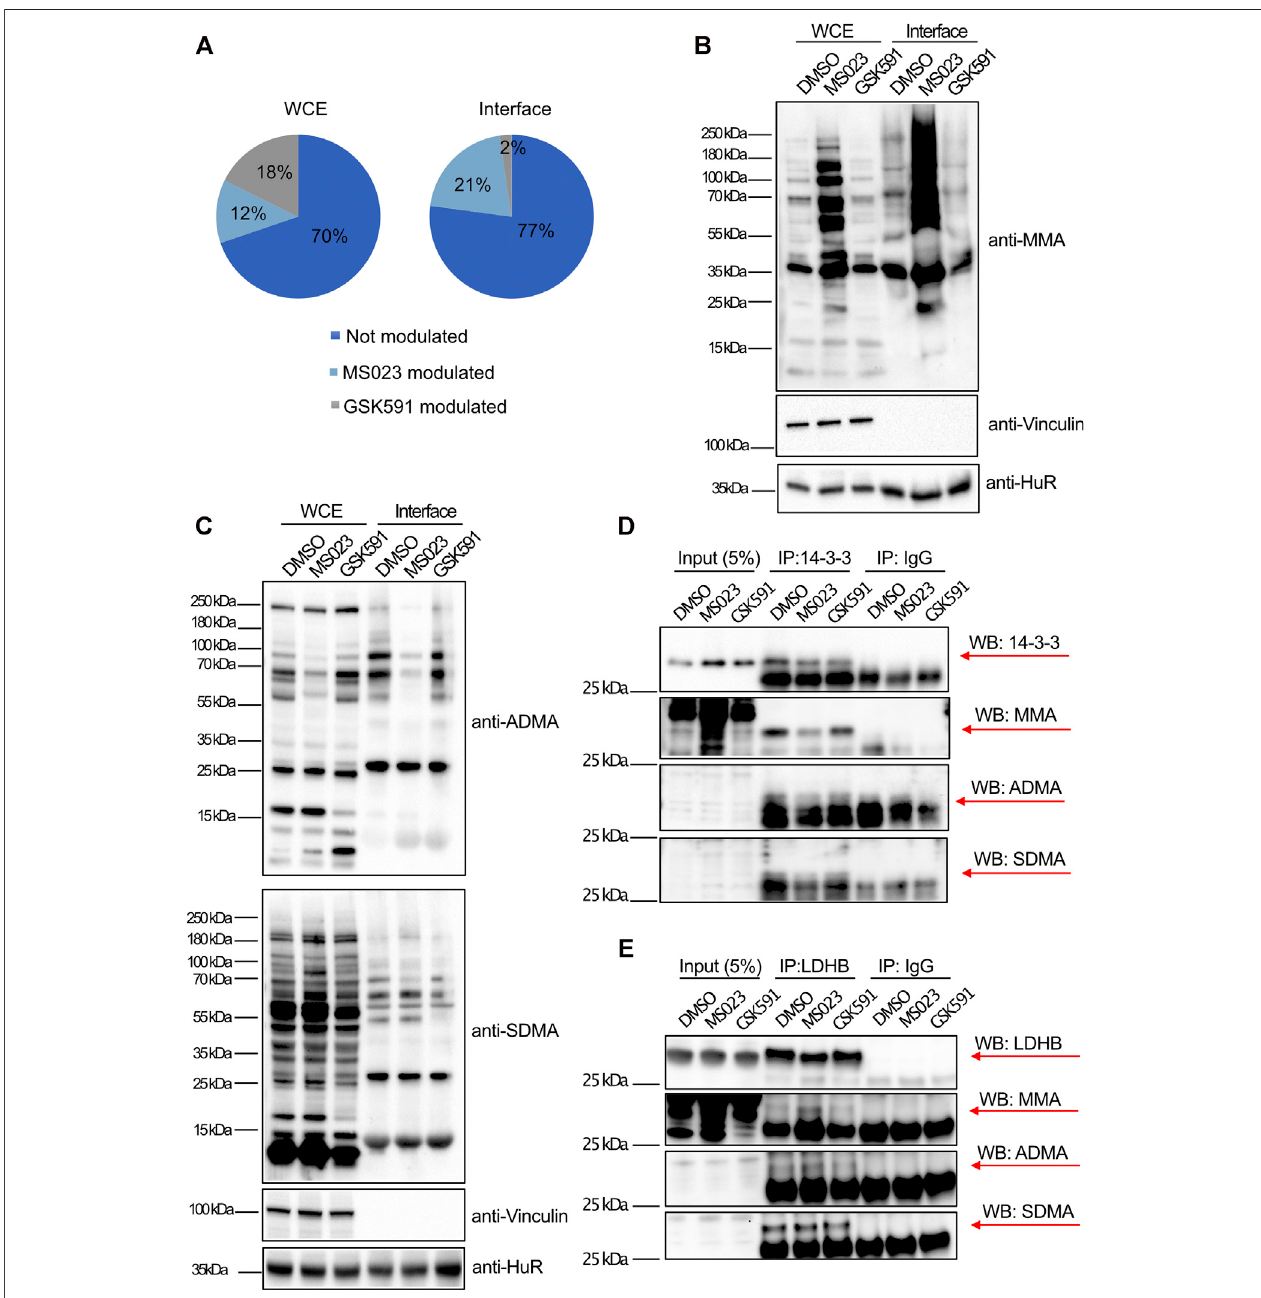
FIGURE 5 | Interface-enriched protein dynamic binding to RNA is associated to their R-methylation state. (A) Percentage of protein modulated in response to PRMTinhibitors.Percentageofproteinsigni fi cantlymodulated( ± 1 σ )wascalculatedindependenceofMS023orGSK591treatment,bothinWCEandinterfacefraction. In the WCE the two treatments equally modulate protein expression (12% regulated by MS023 and 18% by GSK591, respectively), whereas in the interface fraction, RBP-RNA interactions are almost exclusively regulated by MS023 treatment (21% regulated by MS023 and 2% regulated by GSK591, respectively). (B) WB pro fi ling of dynamic regulation of global protein R-mono-methylation (MMA). WB was carried out on aliquots of WCE and interface fraction in control DMSO and upon MS023 and GSK591. Vinculin and HuR protein were used as loading control for WCE and interface, respectively. (C) WB pro fi ling of dynamic regulation of protein asymmetric R-di-methylation (ADMA) and symmetric R-di-methylation (SDMA). WB analysis was carried out on aliquots of WCE and interface fraction in control DMSO and upon MS023and GSK59. Thesame membrane was fi rst probed withanti-ADMA antibody,then stripped and usedtodetect SDMA. Vinculin andHuR protein were used asloading control for WCE and interface, respectively. (D) Protein immunoprecipitation (IP) followed byWB validationofthe R-methylationstate of14-3-3 proteins as representative for MS023-modulated RBPs in the OOPS. The R-methylation states of 14-3-3 protein was assessed upon DMSO, MS023 or GSK591 treatment by proteinIPfollowedbyprobingwiththeanti-pan-methylsantibodiesagainst MMAADMAand SDMA.IgGwereusedasmockcontrolsforIP.For14-3-3proteins MMAis clearly detectable, while ADMA and SDMA signals are ambiguous, due to the cross-contaminating signals of the light chains of denatured antibodies. (E) Protein IP